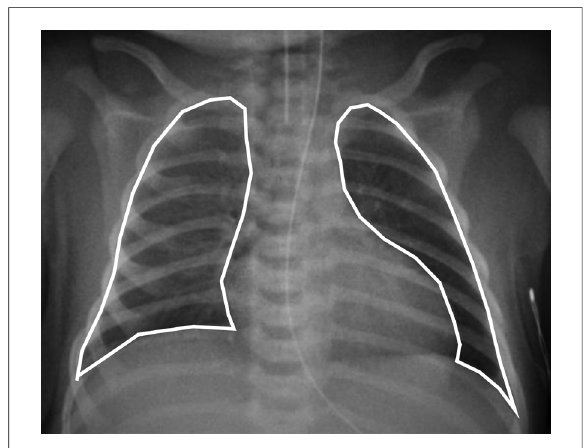
FIGURE 1 A chest radiograph of a term-born infant with poor perinatal adaptation on the fi rst day of life. Method of free hand tracing of the perimeter of the CRTA excluding the mediastinal